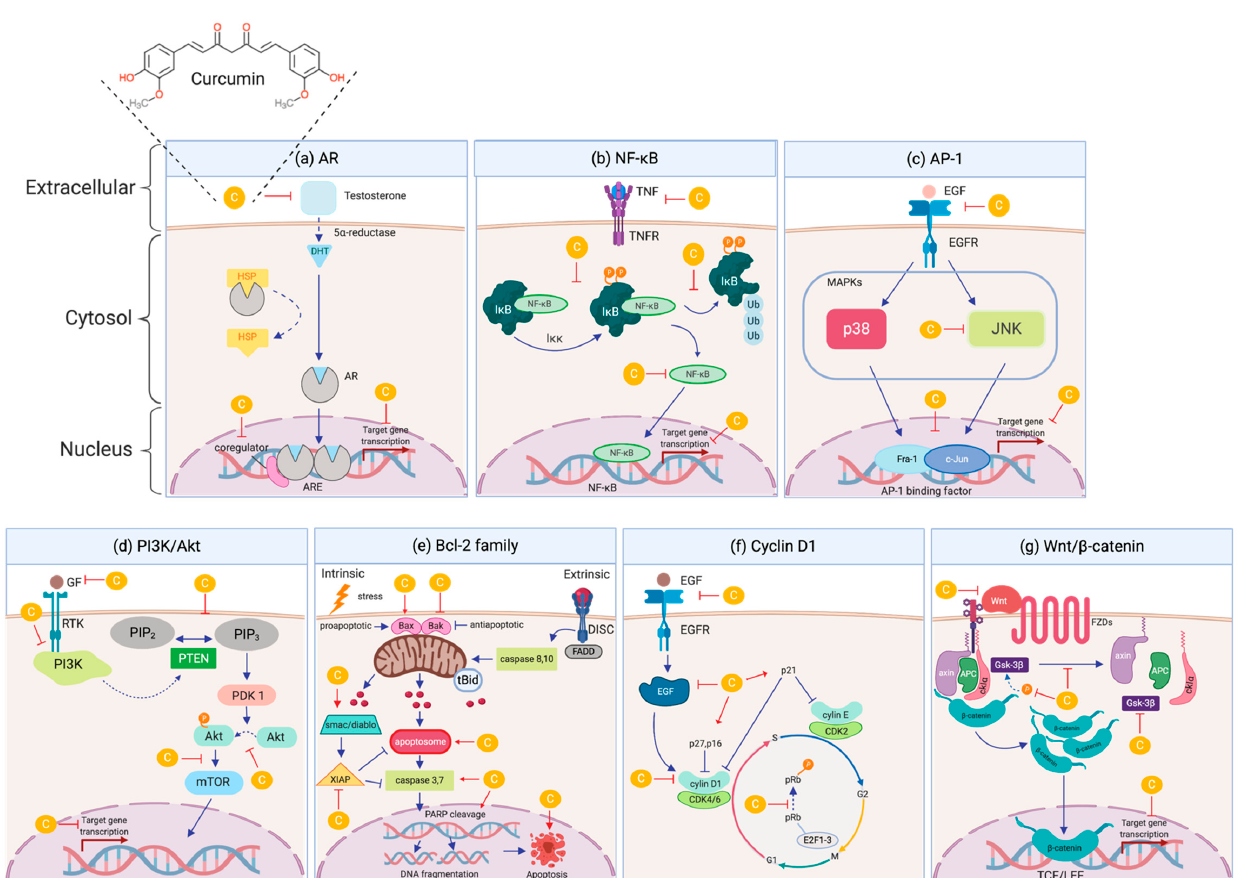
Figure 4. Mode of actions of curcumin as anti-cancer agent on the key molecular targets in aberrant signalling pathways of PCa. Curcumin exhibits anti-cancer properties by inhibiting signalling pathways and molecular targets; ( a ) Androgen receptor (AR) signalling; ( b ) Nuclear factor kappa-B (NF- κ B); ( c ) Activating protein-1 (AP-1); ( d ) Phosphatidylinositol 3-kinases/the serine/threonine kinase (PI3K/Akt); ( e ) B-cell lymphoma 2 (Bcl-2); ( f ) Cyclin D1 and ( g ) Wingless (Wnt)/ß-catenin signalling. Molecular targets and signalling pathways that are induced by curcumin are noted by using → , while the inhibition represented by ⊣ symbol.